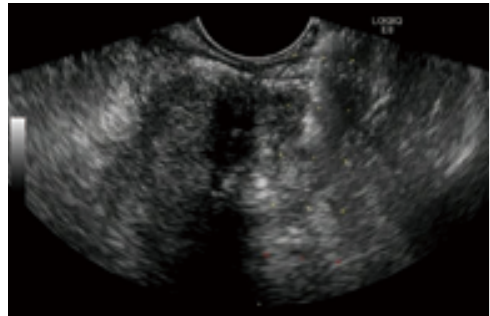
Figure 2 Transrectal ultrasound (TRUS) in a 67-year-old man with bilateral prostate cancer. Although the prostate borders are clearly visible and some intraprostatic structure is seen, no suspicious lesions were identified.